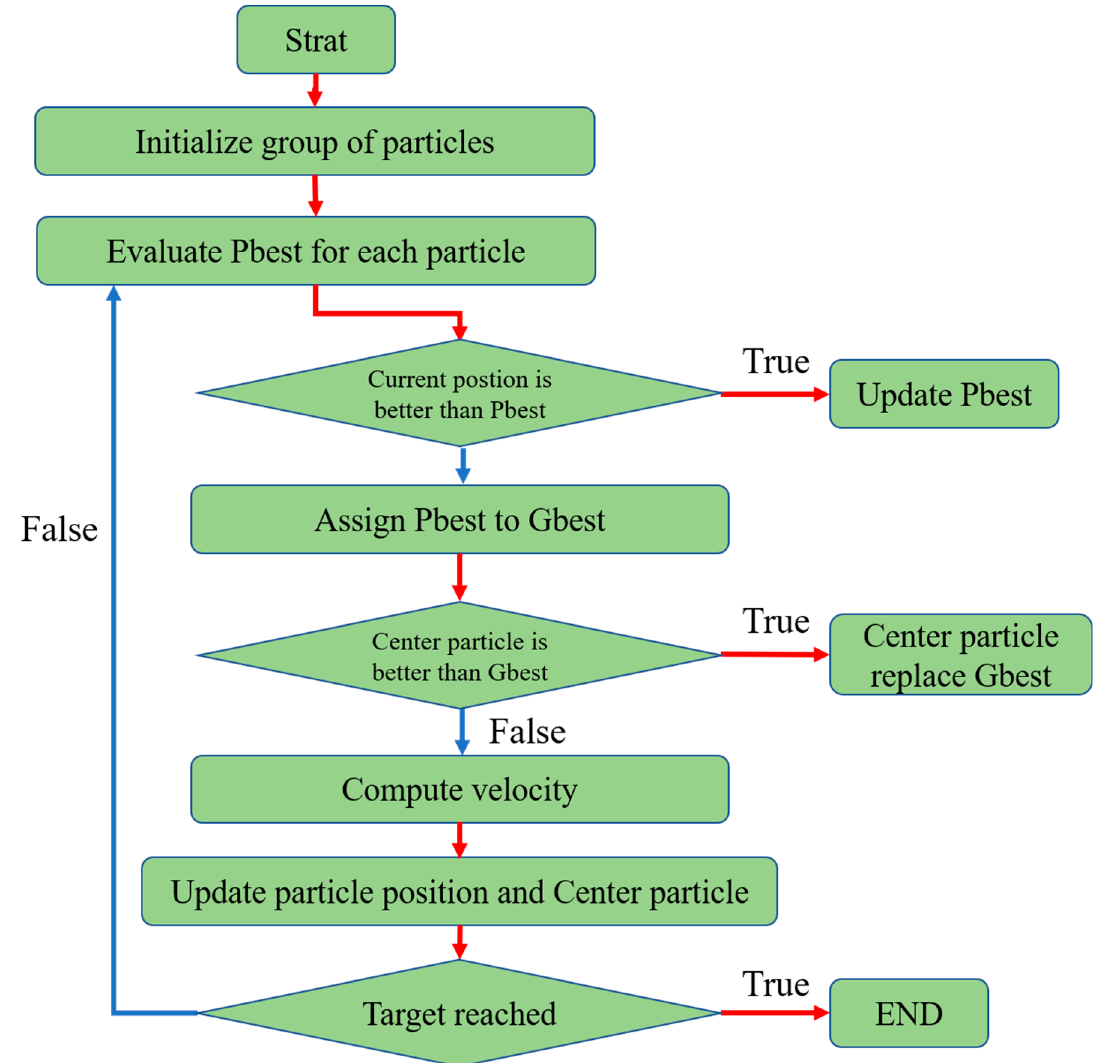
Appl. Sci. 2022 , 12 , x FOR PEER REVIEW Figure 12. Conceptual representation of the CPSO algorithm. Figure 12. Conceptual representation of the CPSO algorithm.